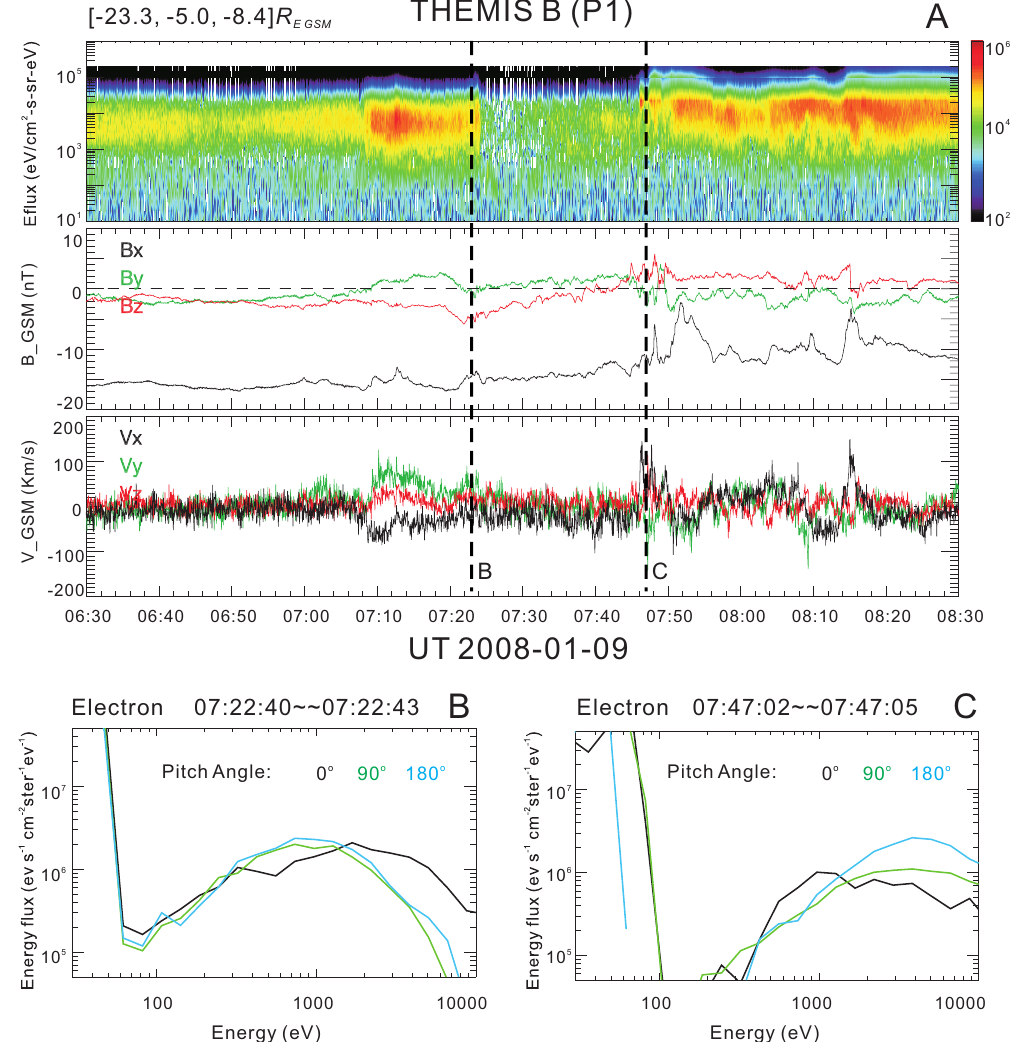
Fig. 4. Detailed observation at P1: panel (A) shows the ion spectra from 10eV to 50keV, the magnetic field and the ion bulk velocity. Panels (B) and (C) give the energy flux spectra of electrons along (0 ◦ ), opposite (180 ◦ ) and perpendicular (90 ◦ ) to the magnetic field for the times marked by the black vertical dashed lines in panel (A)